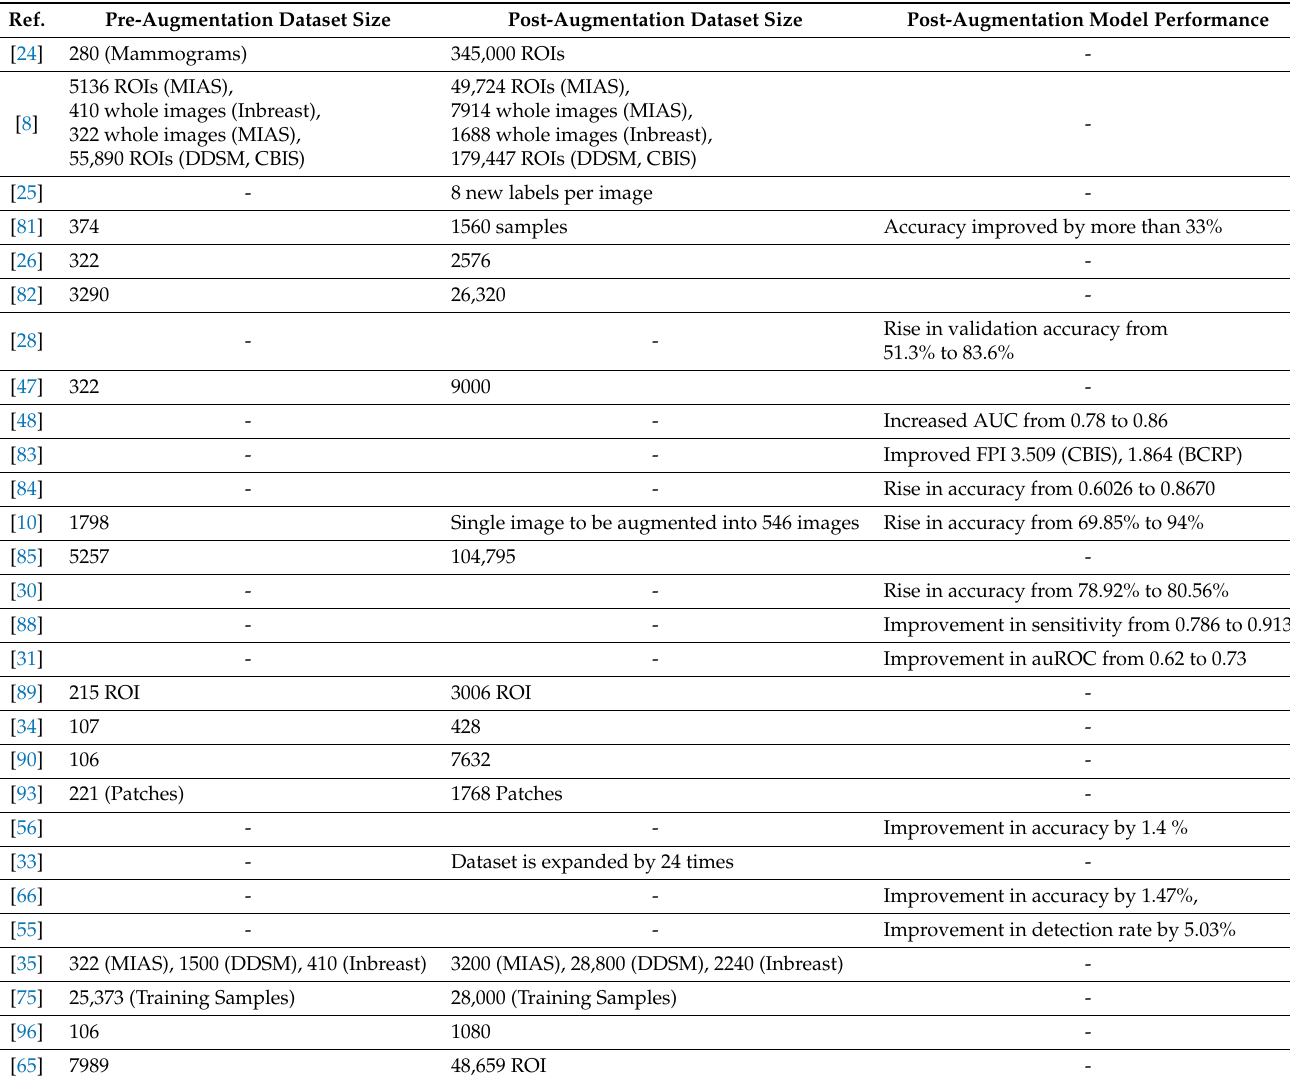
Table 3. Articles with pre and post augmentation dataset size and model